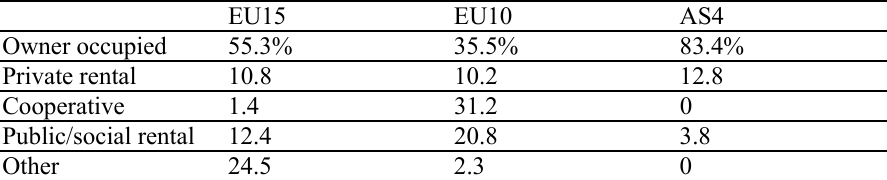
Table 3: the tenure structure in EU countries in